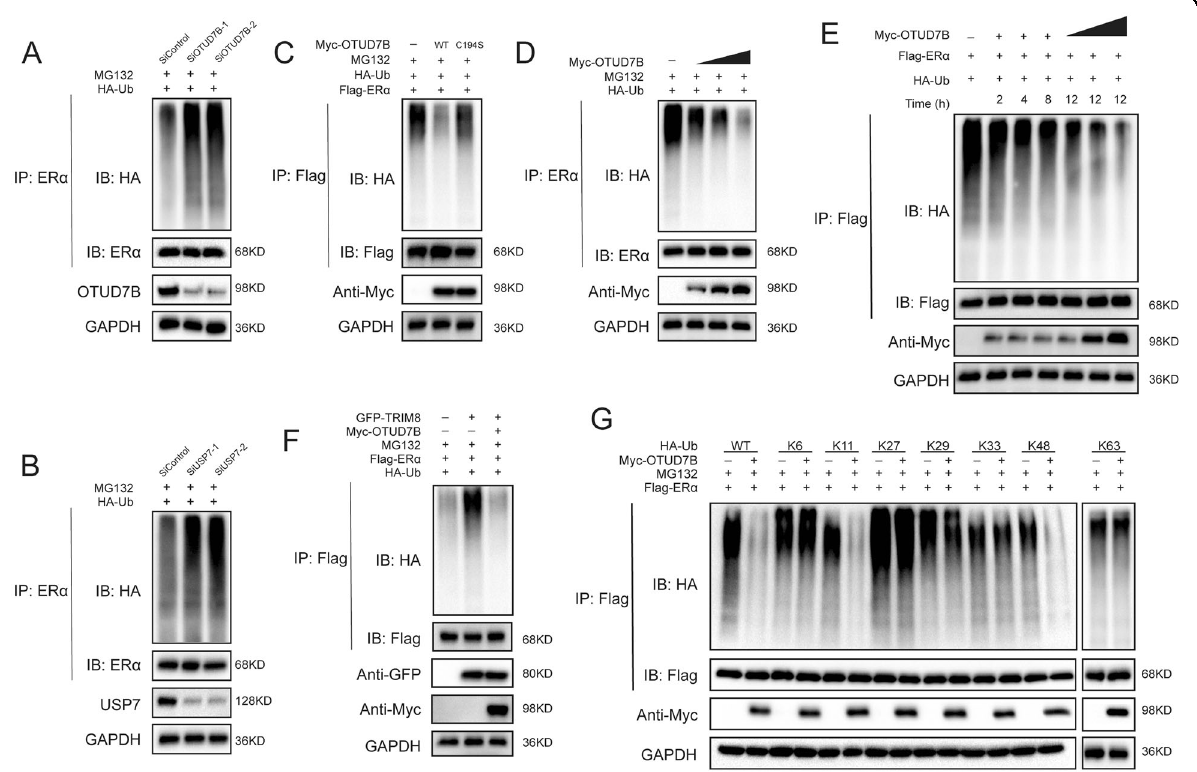
Fig. 6 OTUD7B deubiquitylates ER α . A MCF-7 cells transfected with the indicated siRNA were treated with MG132 for 6 h before collection. ER α was immunoprecipitated with anti-ER α and immunoblotted with anti-HA. B Immunoblotting to detect the ubiquitination of ER α in HEK293 cells cotransfected with Flag-ER α , HA-Ubiquitin, and Myc-OTUD7B (wild type or C194S). C Immunoblotting to detect the ubiquitination of ER α in HEK293 cells cotransfected with Flag-ER α , HA-Ubiquitin, and Myc-OTUD7B (wild type or C194S). D OTUD7B removed the ubiquitin chain of ER α in a dose- dependent manner. E OTUD7B removed the ubiquitin chain of ER α in a time- and dose-dependent manner. F ER α ubiquitylation was analyzed in cells transfected with E3 TRIM8 together with OTUD7B or not. G HA-WT, K6, K11, K27, K29, K33, and K48 or K63 Ub was cotransfected with Flag-ER α and Myc-OTUD7B into HEK293 cells. After treatment with 10 μ M MG132 for 6 h, cell lysates were subjected to ubiquitination assay and the ubiquitination level of ER α was detected by HA antibody. * P value < 0.05, ** P value < 0.01, *** P value <